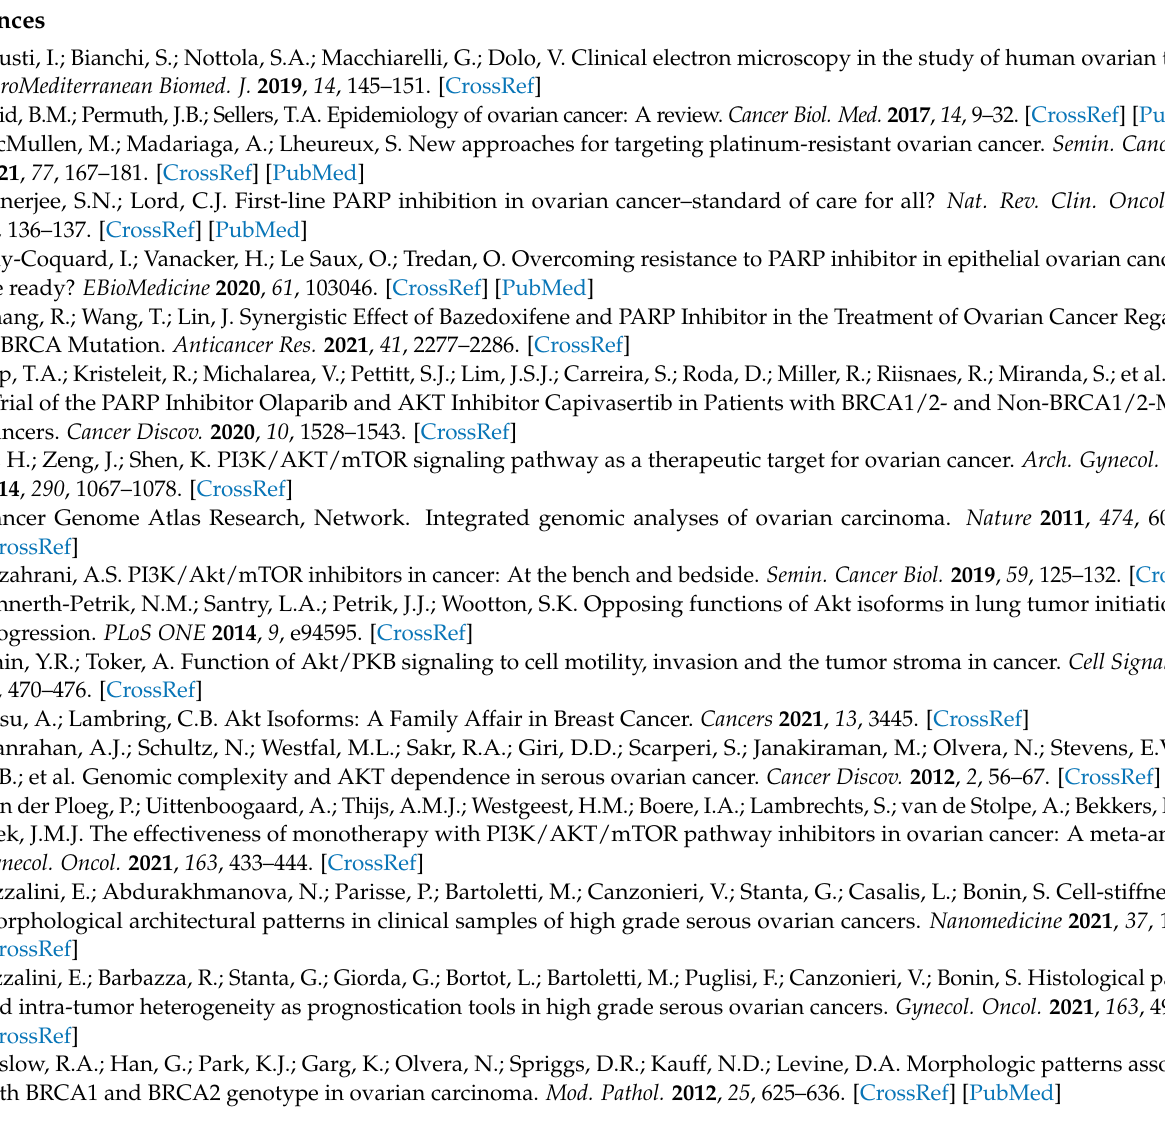
”low/low” group compared to the other AKT categories ( p =